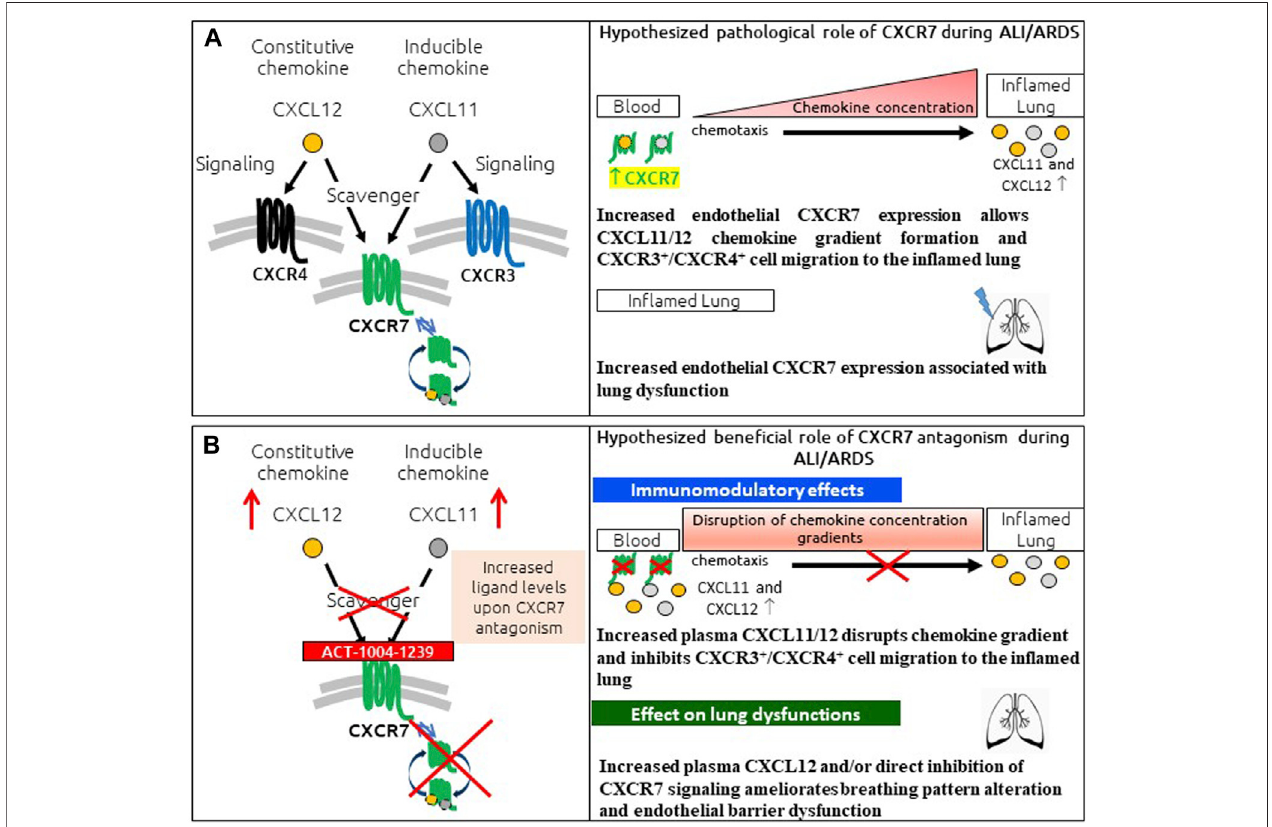
FIGURE 6 | Summary of pathological role of CXCR7 and potential bene fi t of CXCR7 antagonism during ALI/ARDS. (A) CXCR7 functions predominantly as a scavengerreceptorforitstwoligands:theinterferon-induciblechemokineCXCL11andtheconstitutivechemokineCXCL12.Bindingofitsligandsleadstointernalization of the CXCR7 – ligand complex and ligand degradation. CXCL11 and CXCL12 also bind and activate the signaling chemokine receptors CXCR3 and CXCR4, respectively. TheCXCR3/CXCR4/CXCR7axes play animportantroleinlung in fl ammation.CXCR7 scavenging activity tightlyregulatestheextracellularlevelsofits ligands, facilitating the establishment and maintenance of CXCL11/12 chemokine concentration gradients and CXCR3 + /CXCR4 + cell migration from the blood to the in fl amed lung. In addition, increased CXCR7 expression in the in fl amed lung has been reported to be associated with breathing pattern alteration and endothelial barrier dysfunction. (B) CXCR7antagonismwiththeCXCR7antagonistACT-1004-1239exhibitsimmunomodulatoryeffects:byblockingthescavengingactivityofthereceptor and consequently increasing CXCL11 and CXCL12 plasma concentrations, chemokine gradients are disrupted, inhibiting CXCR3 + and CXCR4 + cell migration to the in fl amed lung. In addition, treatment with ACT-1004-1239, by increasing plasma CXCL12 and/or by direct inhibition of CXCR7 signaling, ameliorates ALI-induced breathing pattern alteration and endothelial barrier dysfunction.